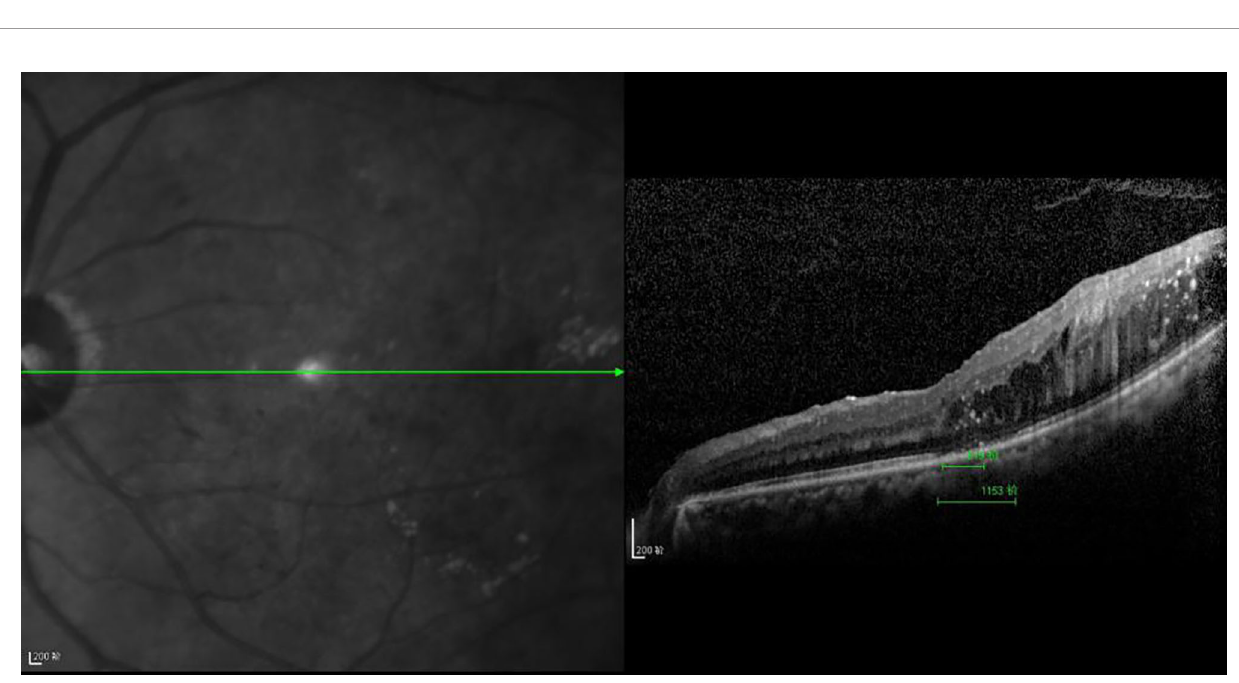
FIGURE 6 | The CFT value is 519 m m, the ELM layer is continuous, the fracture distance of the IS/OS layer is 1,153 m m, and there is outer retinal